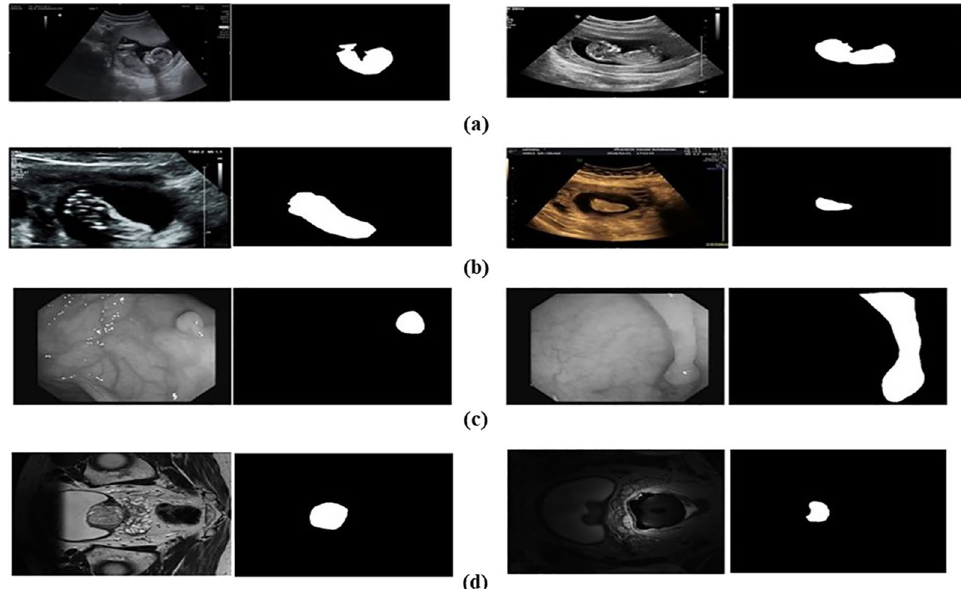
Figure 5. Samples of the CRL Foot-MFP, CVC-ClinicDB, and multi-site MRI datasets together with their corresponding annotation of the target structures. CRL ( a ), Fetal Foot ( b ), CVC-ClinicDB ( c ), Multi-site MRI ( d ).